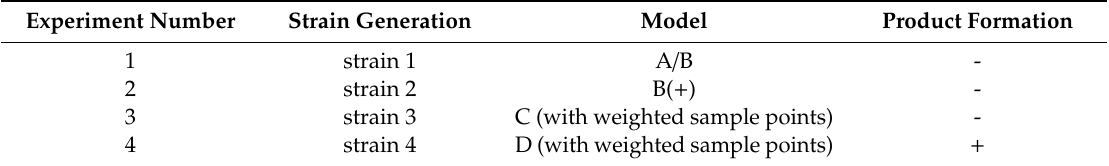
Table 1. List of the experiments with the corresponding strain generations and used models. Experiment Number Strain Generation Model Product Formation strain